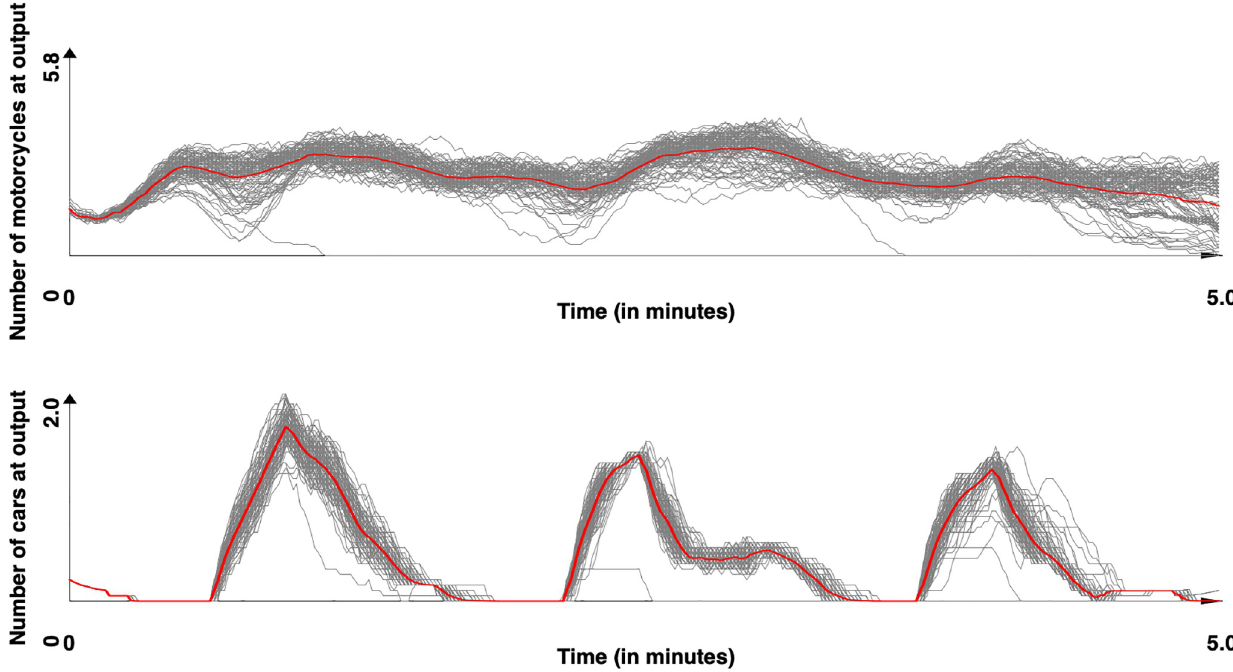
Fig 8. Simulated results for the Tay Son site. Motorcycle and car counts for the 100 simulations with [44] model (time series were smoothed out using moving average with a window size of 10s). In red, the mean values.